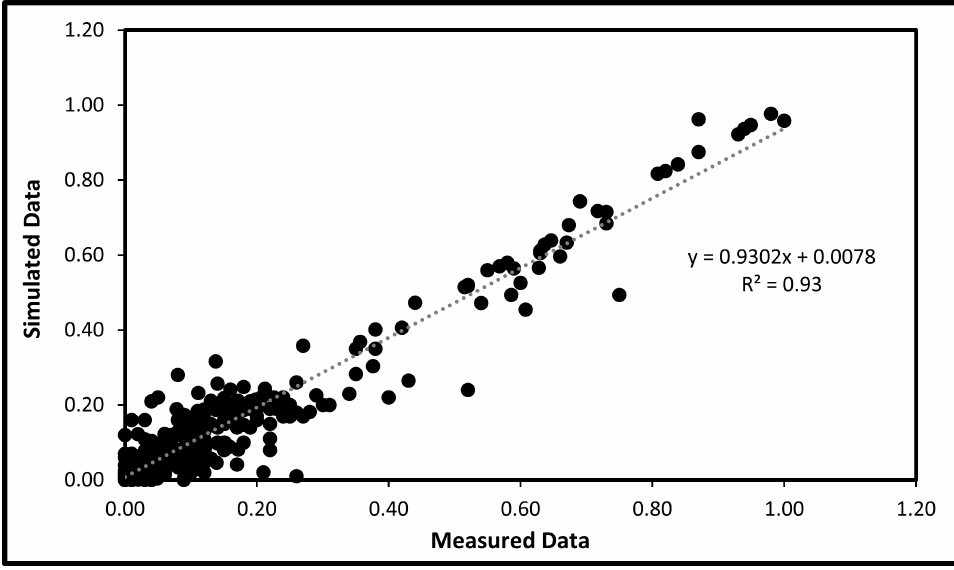
Figure 4. Comparison between predicted and measured data. The measured data correspond to the set of isotopologues of the three experimental conditions, which made it possible to calculate the flux data ( n = 53) at 95% confidence interval and represent four biological replicates per experimental condition. These data are presented in detail in Supplementary Table S5. The linear regression equation and R2 value are